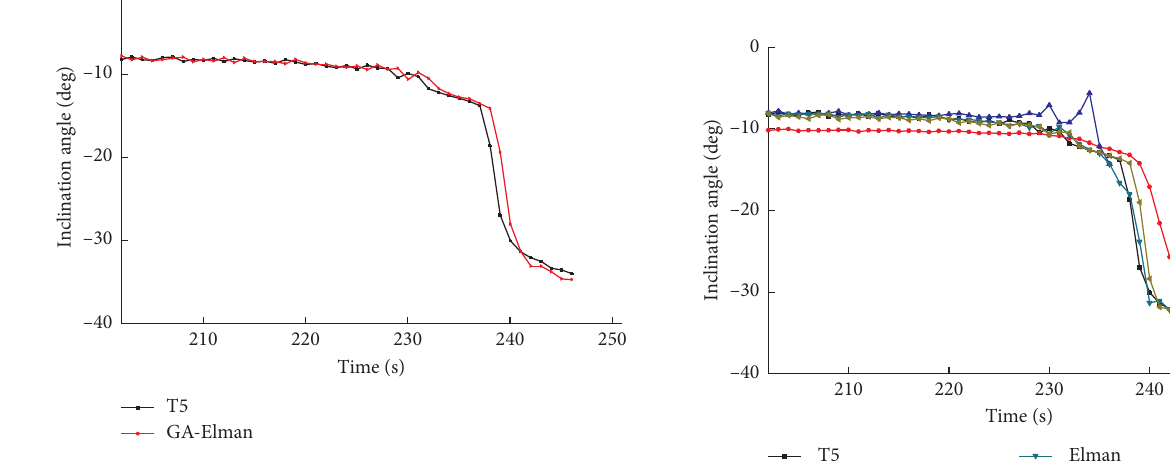
Figure 16: Prediction performance of GA-Elman on the incli- nation angle of T5. Table 3: Comparisons of the evaluation indicators on the incli- nation angle of T5 through different models.